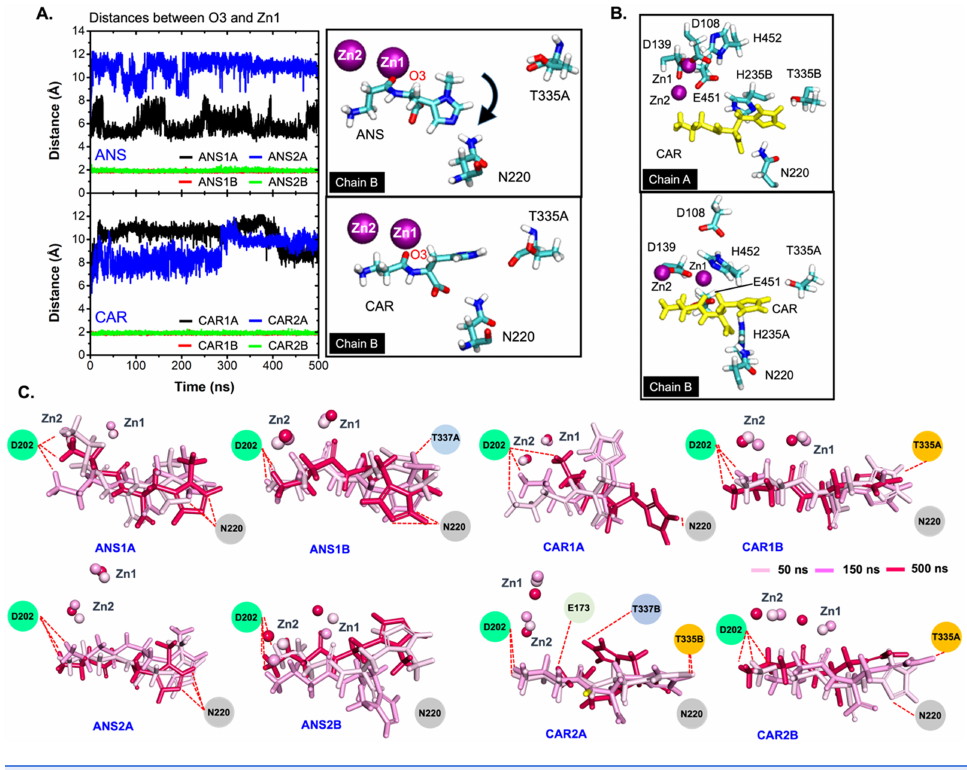
Figure 6 Ligand poses. (A) Distances between Zn 2 + (Zn1) and carbonyl oxygen on each ligand (O3) in all systems. The positions of O3 and Zn1 are shown on the right. The black arrow indicates the flipping di- rection of a histidine ring on ANS. (B) displays the orientations of CAR in the active site of chains A (top) and B (bottom). (C) The snapshots of ligand and two Zn 2 + ions at t = 50 ns, 150 ns, and 500 ns, respec- tively. Full-size DOI: 10.7717/peerjpchem.25/fig-6